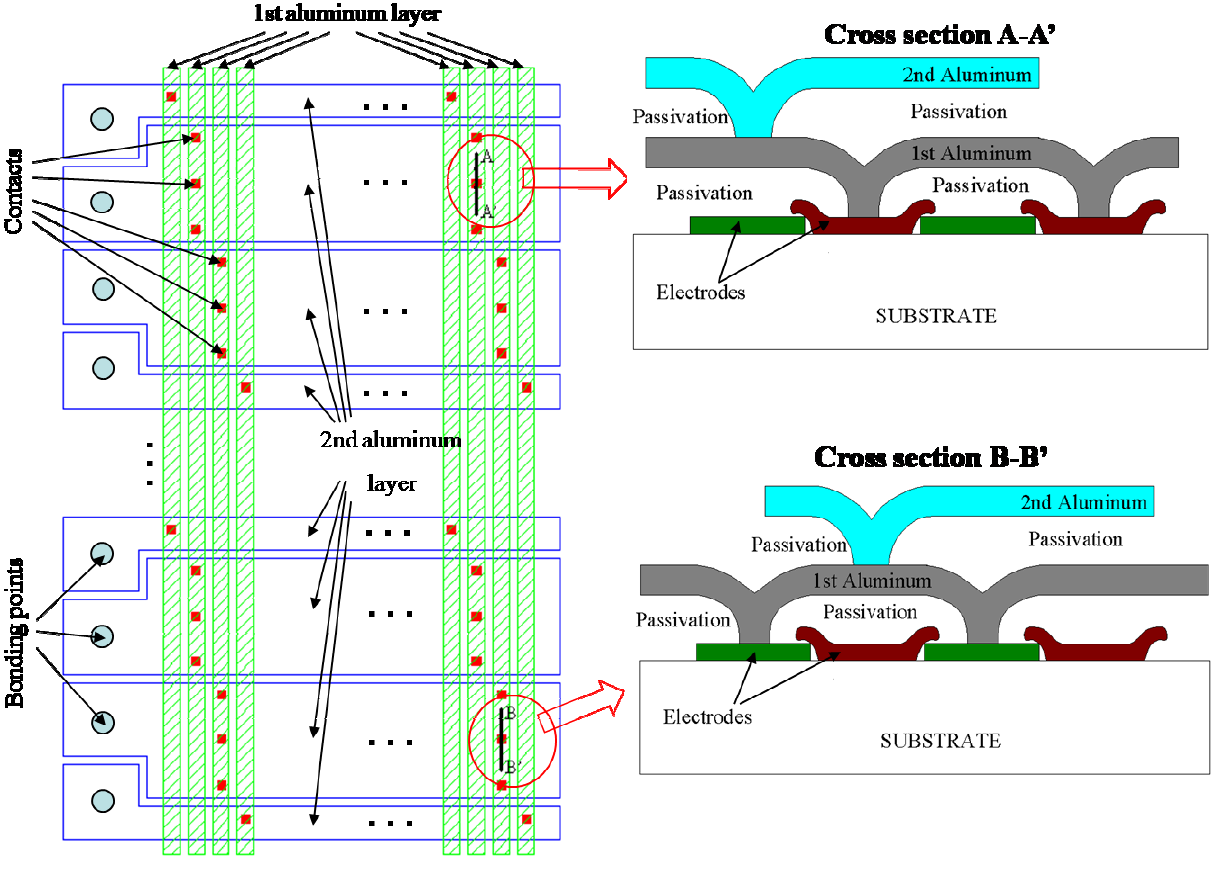
Figure 10. Bus line arrangement of the